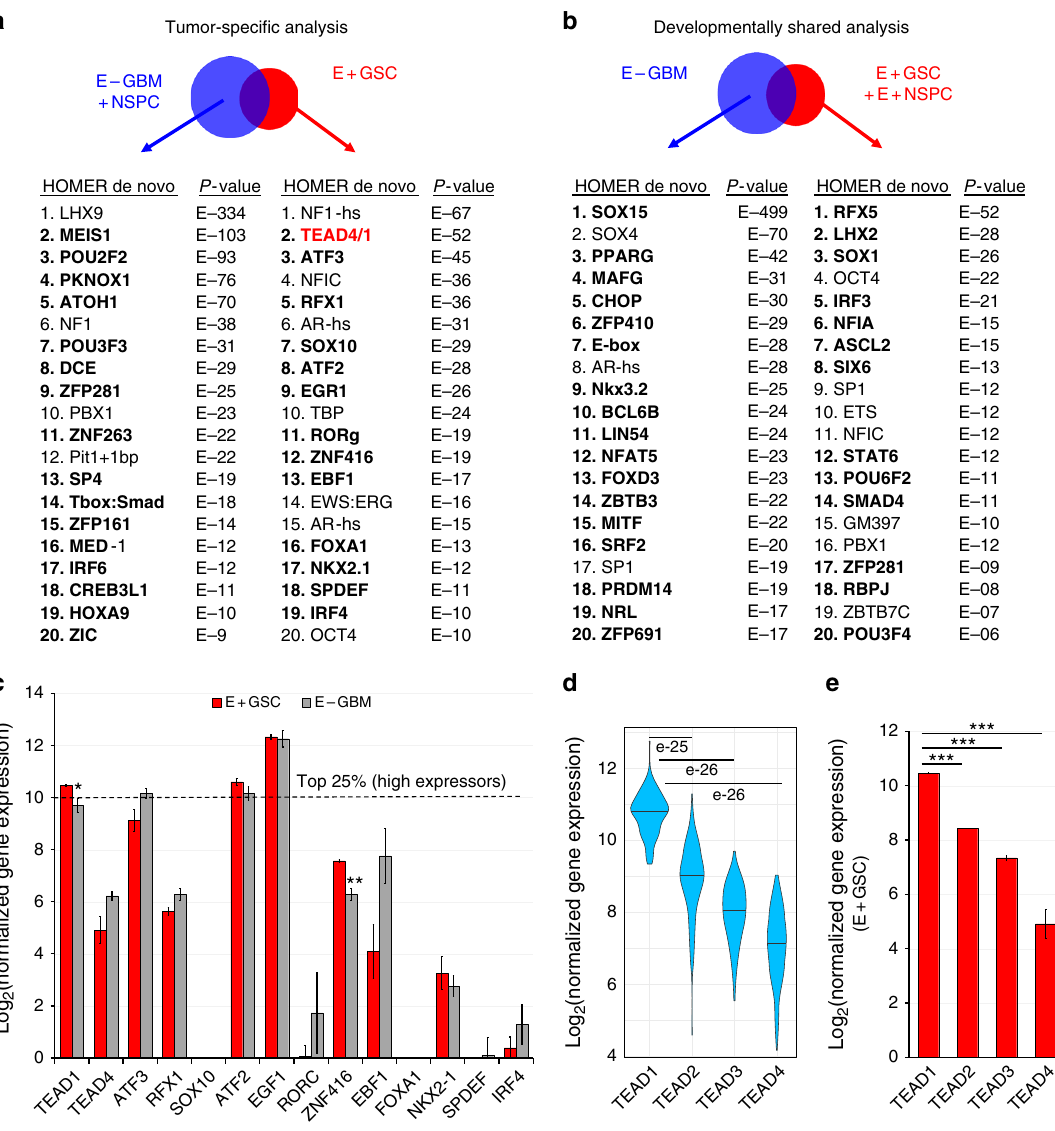
Fig. 2 TEAD is the top selectively enriched motif at GSC-speci fi c open chromatin and TEAD1 is its most highly expressed family member across GBMs a , b Homer de novo motif discovery outlines the 20 most highly enriched TF motifs at chromatin accessibility regions de fi ned by the GSC tumor-speci fi c ( a ) and developmentally shared ( b ) differential ATAC-seq peak analyses (motifs in bold show selective enrichment in only one peak set). The TEAD motif (with highest scores for TEAD4 and TEAD1) is the top, selectively enriched motif within differential GSC tumor-speci fi c peaks (in red). See also Supplementary Data 1. c Bar graph of rld-normalized gene expression values for all signi fi cantly and uniquely enriched GSC tumor-speci fi c TF motifs, generated from parallel RNA-seq data in E + GSC and E − GBM populations. TEAD1 is the only highly expressed gene (top 25th percentile), which is differentially overexpressed in E + GSCs (* p = 0.0496 for TEAD1, ** p = 0.006 for ZNF416, n = 3. Bars represent mean ± SEM). d Violin plot of TEAD1-4 expression in TCGA GBM RNA-seqV2 data ( n = 150) shows that TEAD1 is the most highly expressed TEAD family member, followed by TEAD2 , TEAD3 , and TEAD4 . Expression shown is log2(normalized counts + 1), normalized as detailed in methods. p -Values from one-sided Wilcoxon matched pairs test. Bar represents median value. e Bar graph of rld-normalized gene expression values for TEAD1-4 derived from RNA-seq E + GSC data (*** p < 0.001; n = 3. Bars represent mean ±